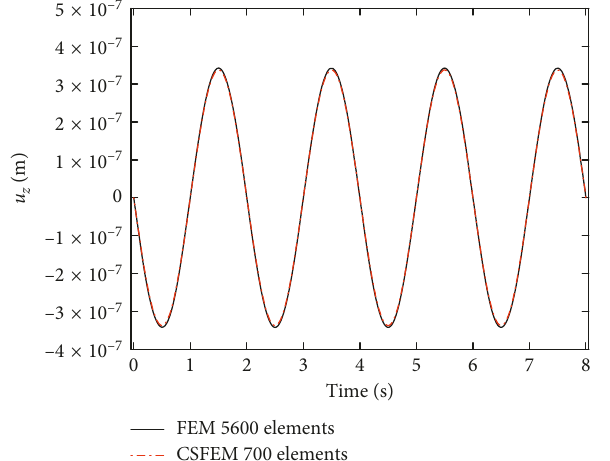
Figure 29: The variation of the displacement u harvester at point B with respect to time.